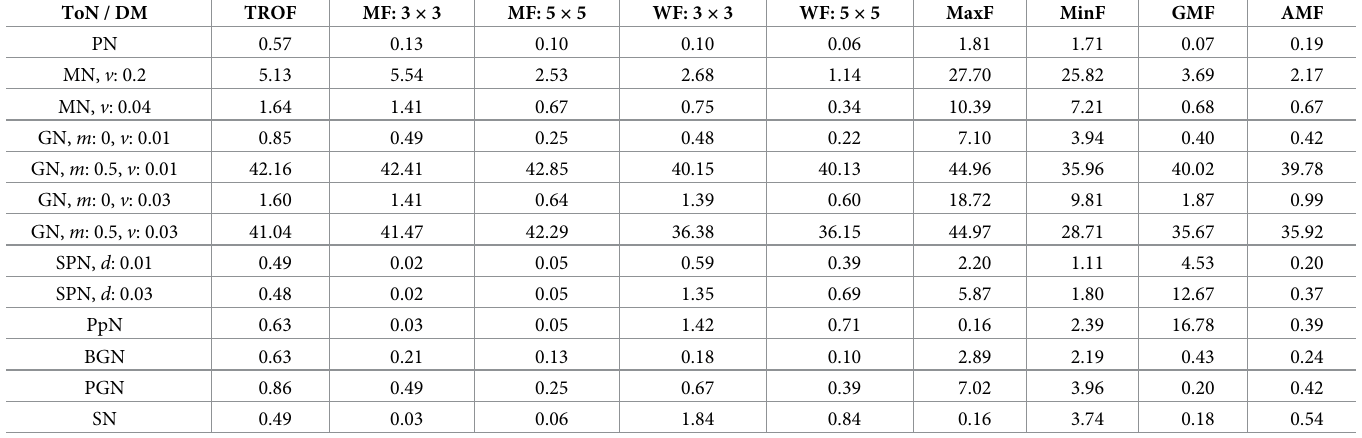
where l and B represent the pixels corresponding to the original image after denoising, ( i , j ) ( i , j ) and S represents the mean variance. The comparison of variances between denoised images and original image using EMDS-5 are shown in Table 3. From the comparison in Table 3, we find that our EMDS-5 is useful to test and evaluate image decisioning methods effectively. For example, increasing the mean value of Gaussian noise will result in greater variance between the denoised images and the original images, indi- cating that the results after denoising are not very stable. In addition, we chose to use the most well-known Image Quality Assessment (IQA) to evalu- ate the image quality of the denoised images. Here we use two indicators, Peak-Signal to Noise Table 3. A comparison of variances between denoised images and original image using EMDS-5. (In [%].). ToN / DM TROF MF: 3 × 3 PN MN, v :